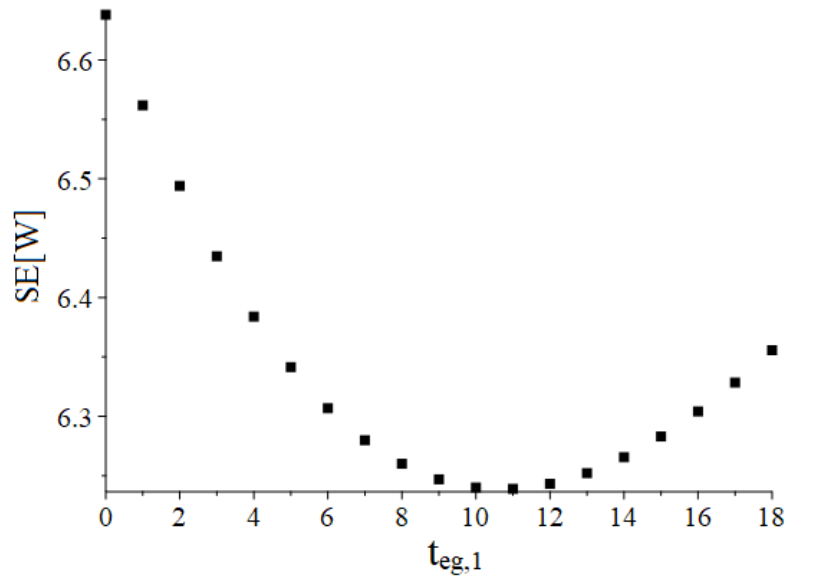
Figure 7. Expected waiting time as a function of t eg ,1 .